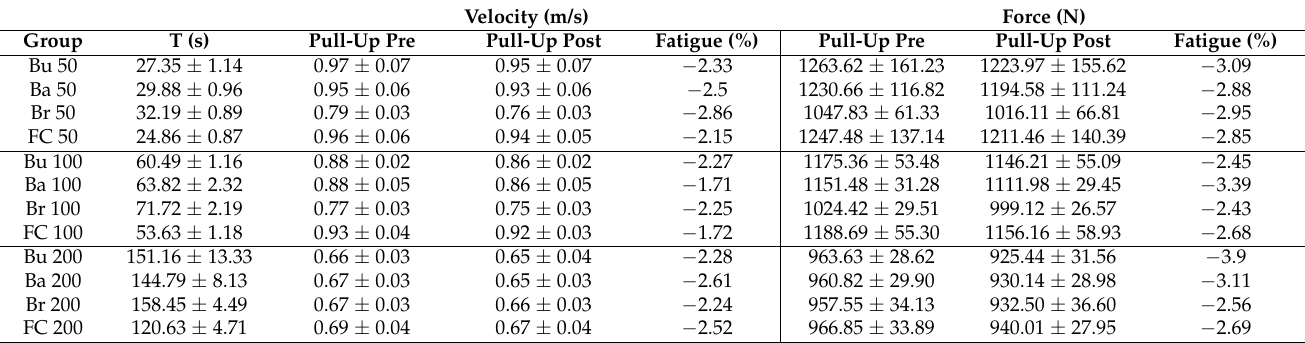
Table 1. Descriptive table of